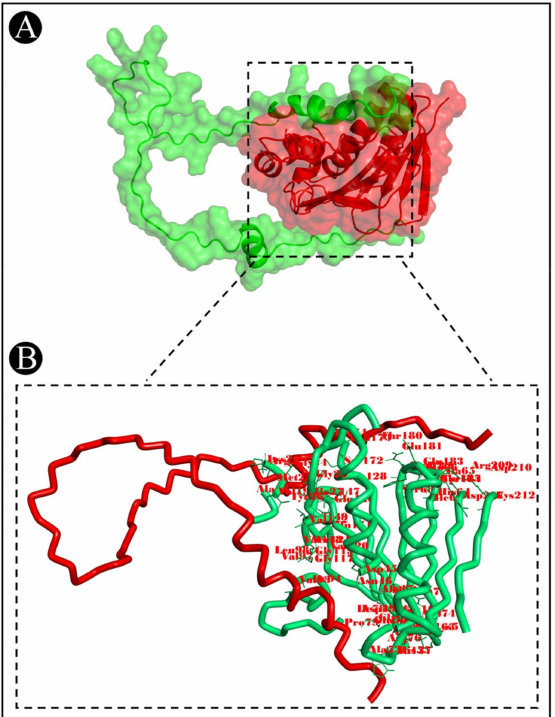
Figure 9. Docking representation of the acidocin A and 6F86 complex. ( A ) The binding interface of the complex, ( B ). the binding interaction between the amino